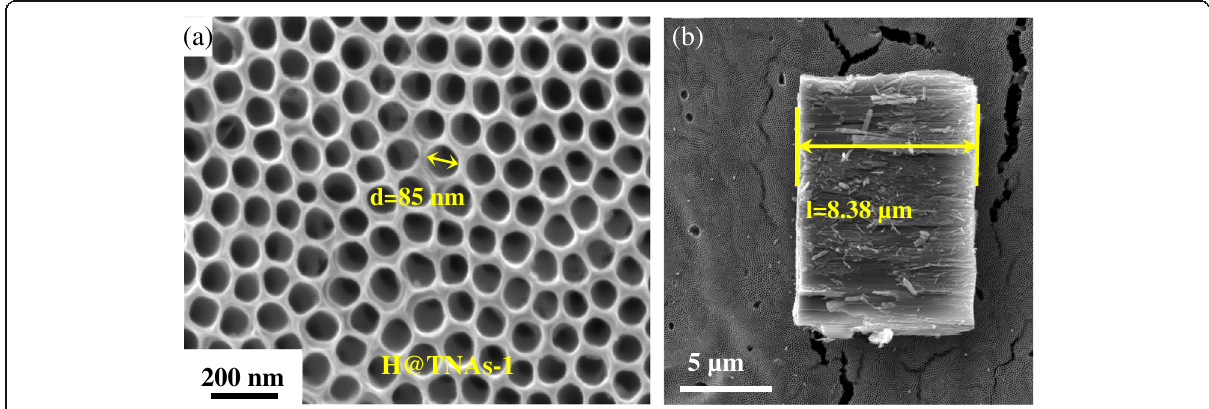
Fig. 2 SEM images of H@TNAs-1. a The top view. b Cross-section of H@TNAs-1